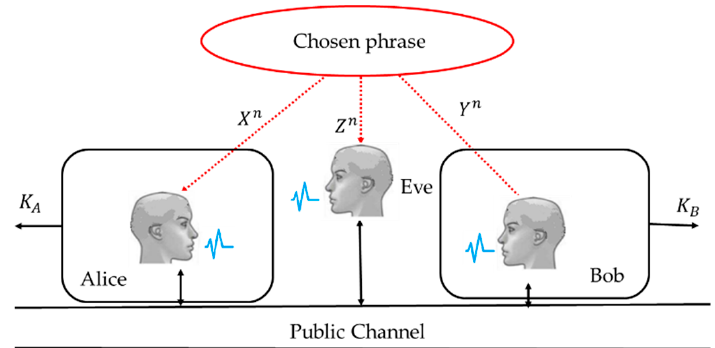
Figure 2. Secret-key distillation using public channel based on the speech signals obtained by pronouncing the chosen phrase.